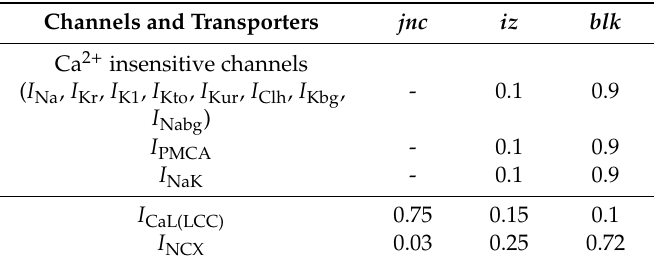
Table 1. Distribution of plasma membrane channels and